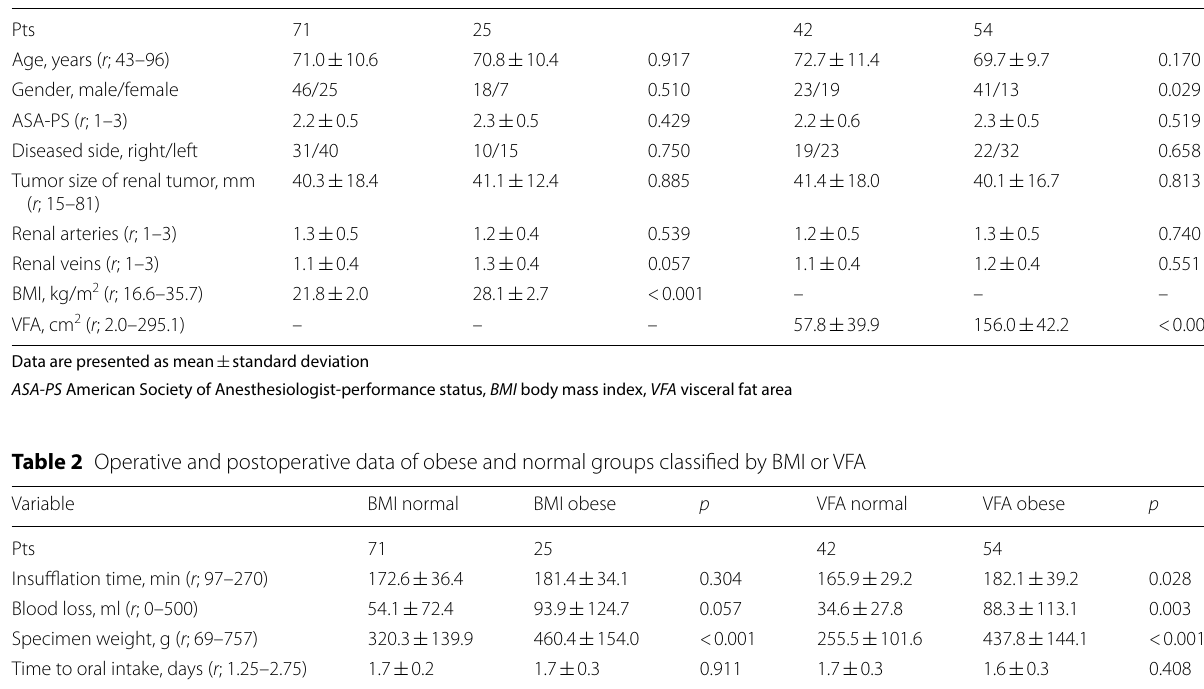
Table 1 Demographics and preoperative factors of obese and normal groups classified by BMI or VFA